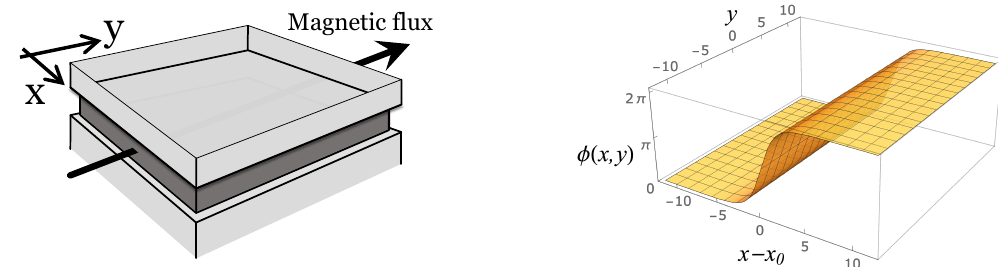
Figure 1: Left: A magnetic flux applied to a insulator layer by a uniform magnetic field in y -direction. Right: 2 π -kink phase difference φ ( t , x ) induced by the magnetic flux ( m =